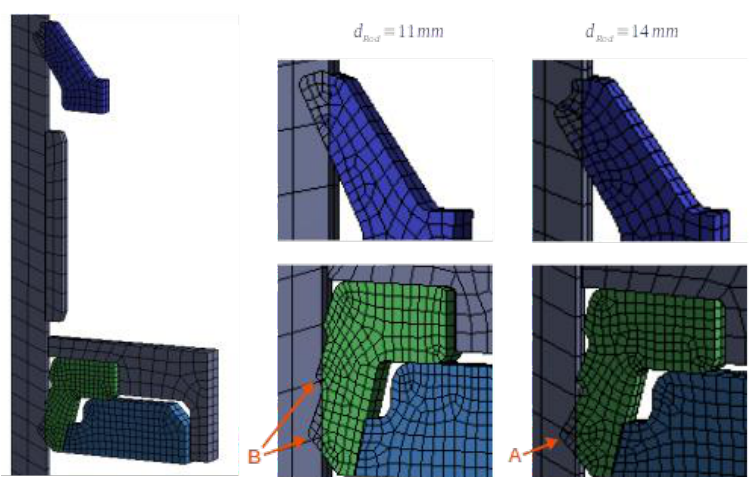
Figure 11. Mesh overview of the target rod diameter geometry ( left ); comparison of mesh details of the source ( center ) and the target geometry ( right ) with the related lips of the oil seal in contact with the rod (A) and (B).